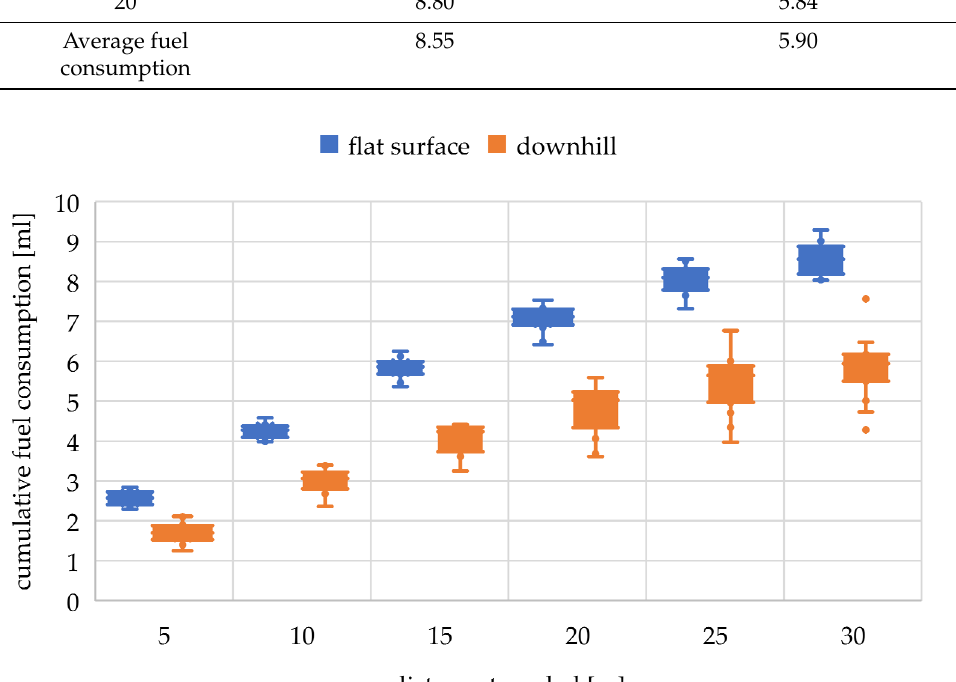
Figure 3. Overview of cumulative fuel consumption depending on the distance traveled. Source: author.